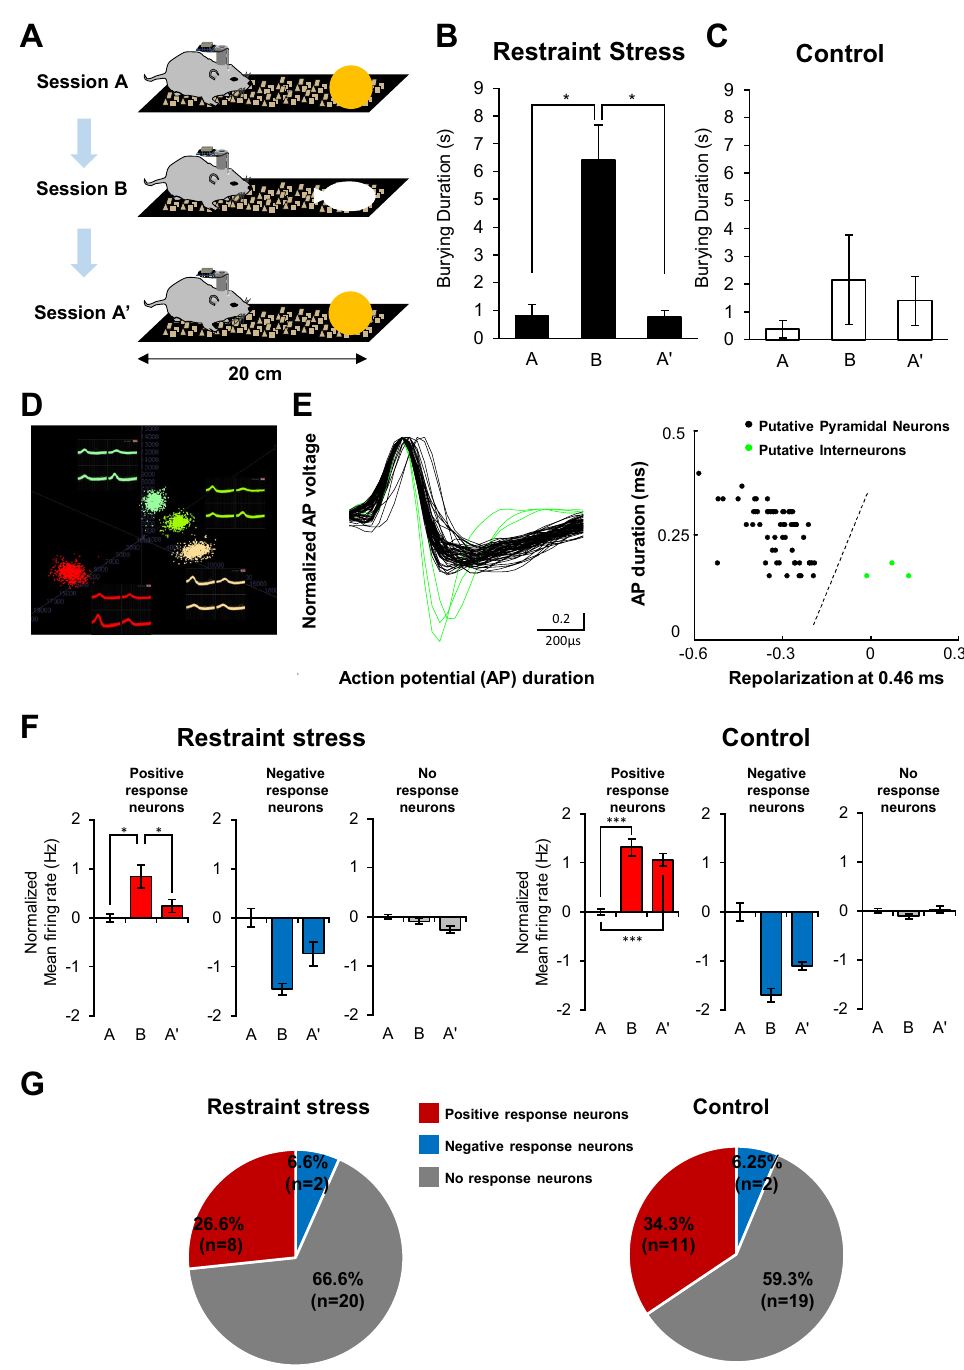
Figure 4. Extracellular single-unit recording of aIC neurons during fear and anxiety-like behavioral assessments. ( A ) Illustration depicting the sequence and experimental setting of behavioral test used for single-unit recording. Mice were presented to a neutral object (session A), restrainer-resembling object (session B), and neutral object (session A’) in sequence. ( B ) Burying duration of mice that experienced restraint stress during the A, B, A’ sessions (n = 5 mice; H(2) = 8.783, p = 0.012, Kruskal–Wallis Test). ( C ) Burying duration of control mice during the A, B, A’ sessions (n = 3 mice; H(2) = 0.655, p = 0.721, Kruskal–Wallis Test). ( D ) Example of a spike-sorting image of isolated single-unit neuronal signals. ( E ) Shapes of recorded action potential (AP) of all individual neurons (left). Each line represents the shape of an action potential of a neuron. Recorded unit neurons were divided into putative-pyramidal neurons or putative-interneurons based on the recorded action potential repolarization time. Putative-pyramidal neurons: black lines or dots. Putative-interneurons: green lines or dots. ( F ) Normalized firing rate of positive (red; stress N = 8, H(2) = 10.343, p = 0.006; control n = 11, H(2) = 22.653, p = 0.001), negative (blue; stress n = 2, H(2) = 4.706, p = 0.095; control n = 2, H(2) = 1.176, p = 0.555), and no-response (gray; stress n = 20, H(2) = 0.642, p = 0.725; control n = 19, H(2) = 2.702, p = 0.259) neurons recorded from restraint stress and control groups during sessions A, B, and A’. Kruskal–Wallis Test was used to test statistical significance of among sessions. ( B , C , F ) A post-hoc Dunn’s test was used to identify significant differences between sessions (* p < 0.05, ** p < 0.01, *** p < 0.001). ( G ) The relative ratio of positive, negative, and no response neurons in each group. Chi-square tests were used to compare the proportions of response neurons in each group (p =